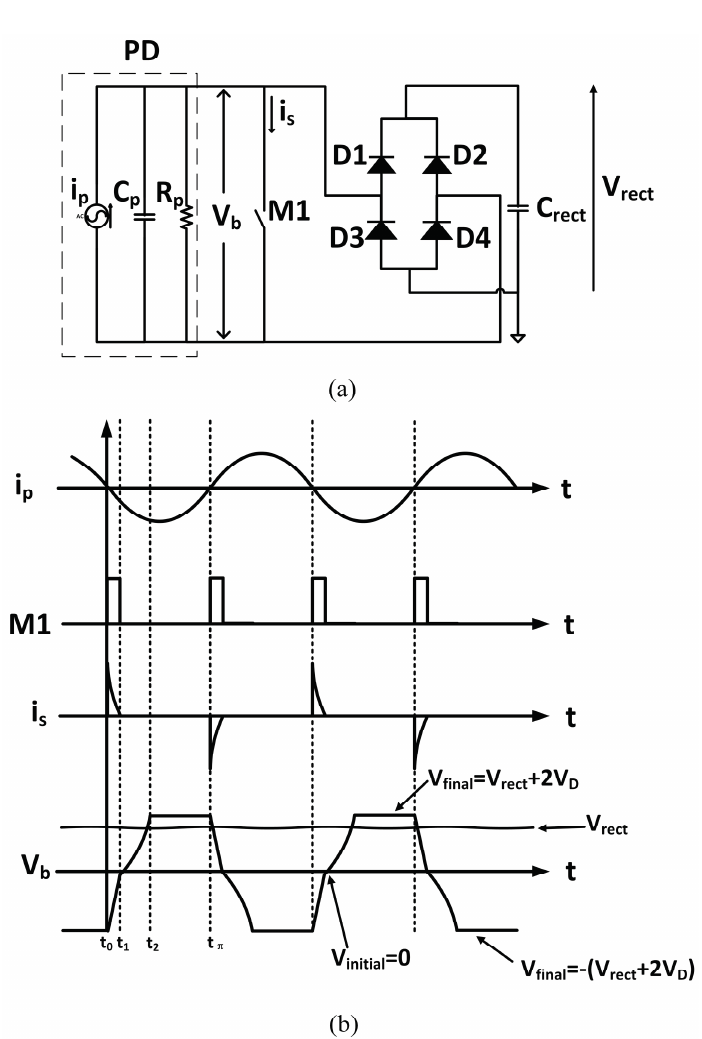
Figure 5. ( a ) Proposed rectifier scheme; ( b ) Associated voltage and current